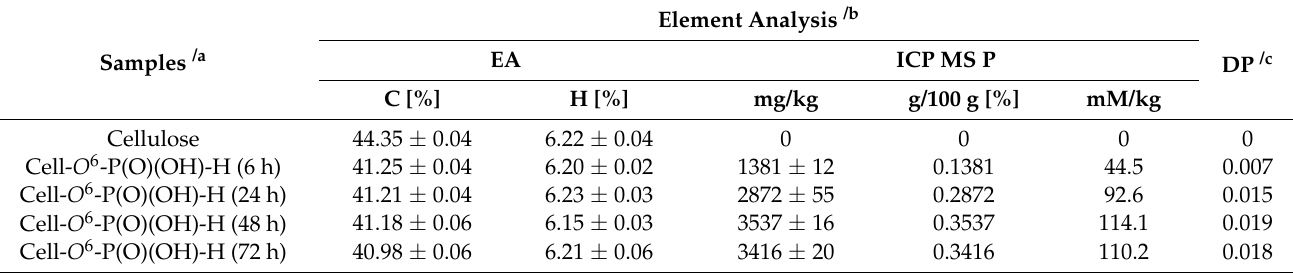
Table 8. The results of elemental analysis of Cell-O 6 -P(O)(OH)-H samples.